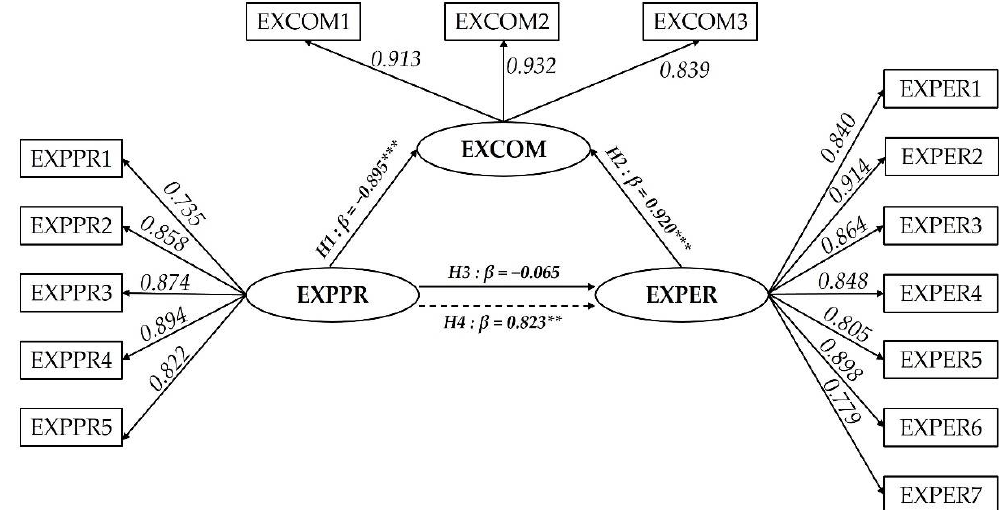
Figure 2. Finalized Model.